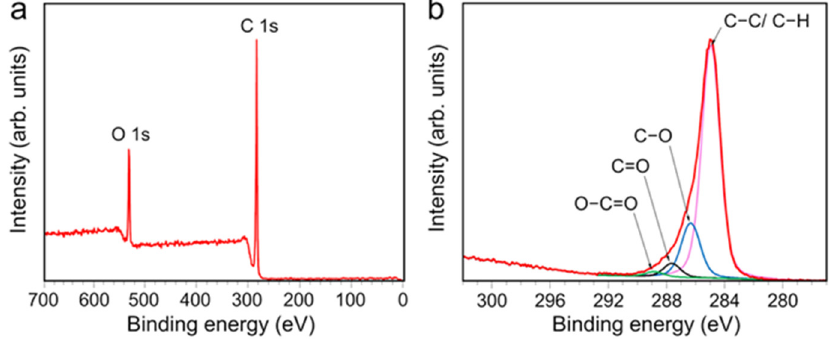
Figure 4. XPS of AP-PP-lim nano-thin films. ( a ) XPS survey spectrum and ( b ) core-level of C 1 s